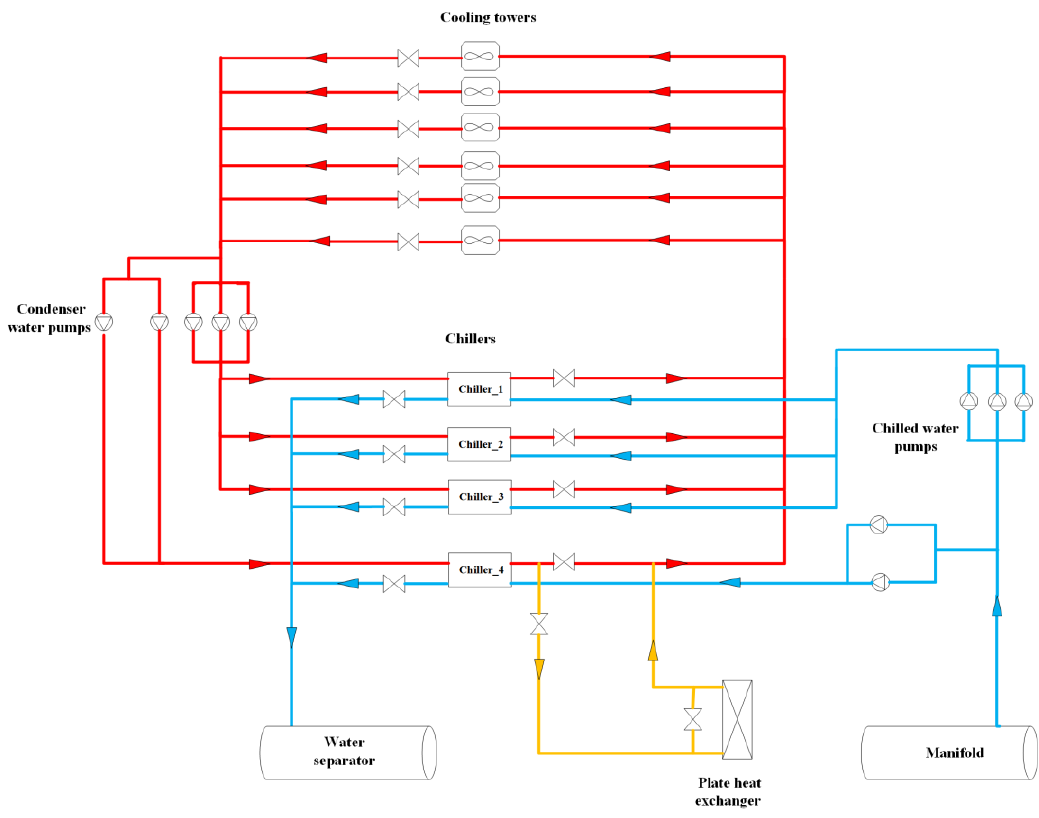
Figure 6. Schematic drawing of the cooling system.